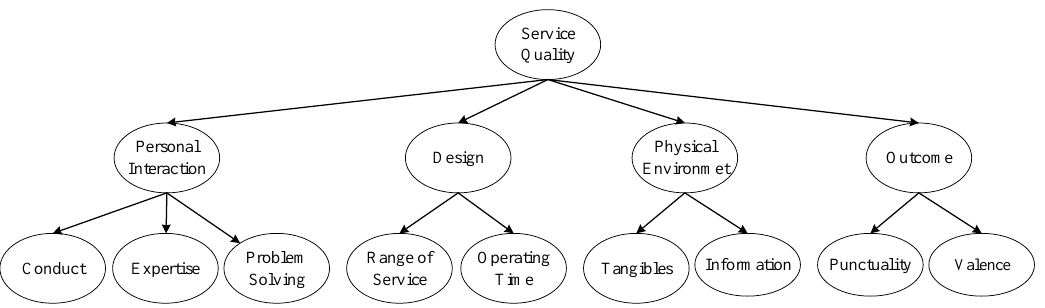
Figure 8. Dimensions of service quality in urgent transport